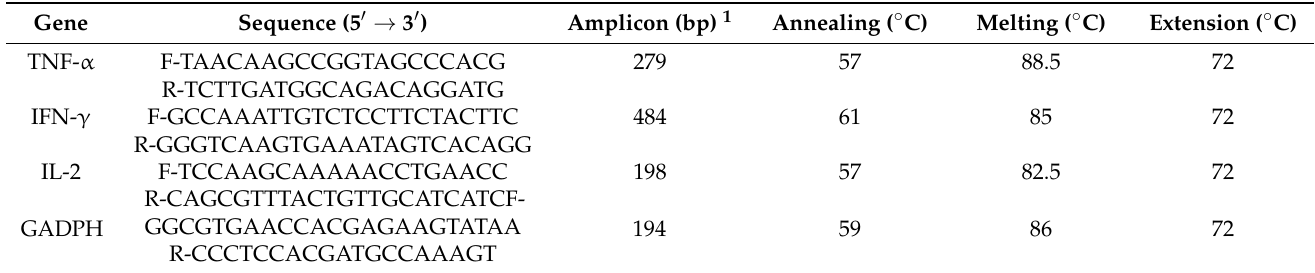
Table 2. Primer sequences used for amplification of the mRNAs for the cytokines TNF- α , IFN- γ , IL-2, and glyceraldehyde 3-phosphate dehydrogenase (GAPDH).